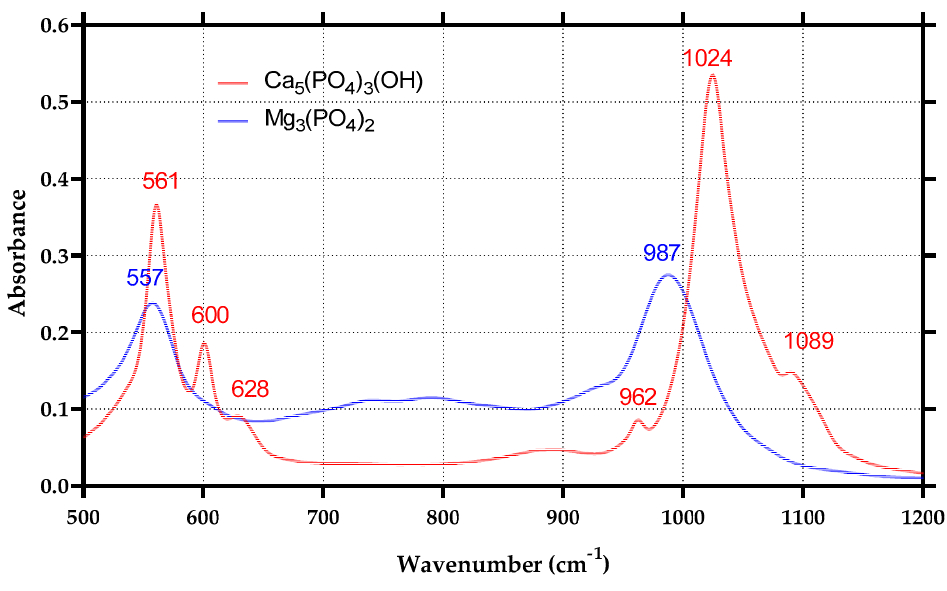
( d ) Figure 1. X-ray diffractogram ( a ), TEM image ( b ), HR-TEM image ( c ), and SAED pattern ( d ) for HA nanopowder.